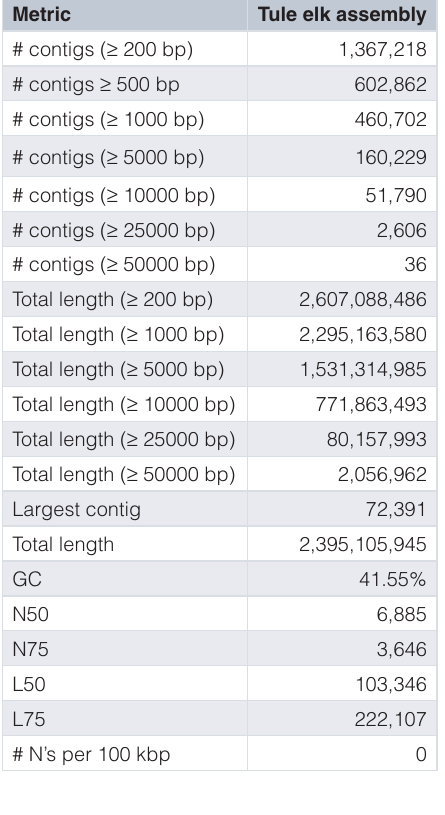
Table 1. Quality metrics on tule elk ( Cervus canadensis nannodes ) assembly, as generated with QUAST